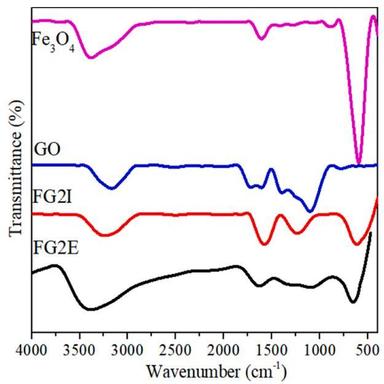
FTIR spectra of GO, Fe3O4, FG2I, and FG2E materials.